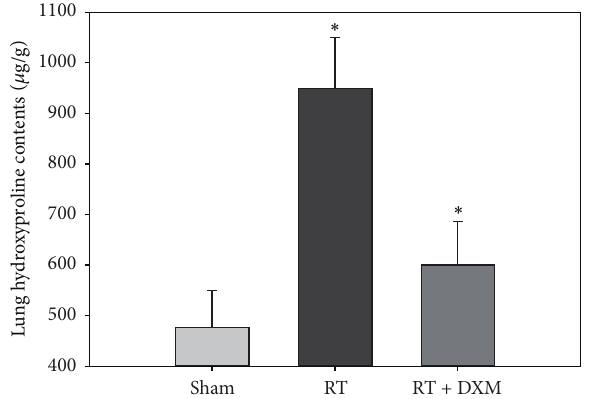
Figure 4: Content of lung hydroxyproline was determined by alkaline hydrolysis assay. Hydroxyproline content was significantly higher at 16 weeks than Sham group. Dexamethasone reduced lung hydroxyproline content which can reflect the content of collagen. ∗ 𝑃 < 0.001 versus RT group and Sham group at correspond- ing time points. Data are presented as the mean ± SD ( 𝑛 = 8 /group/experiment).